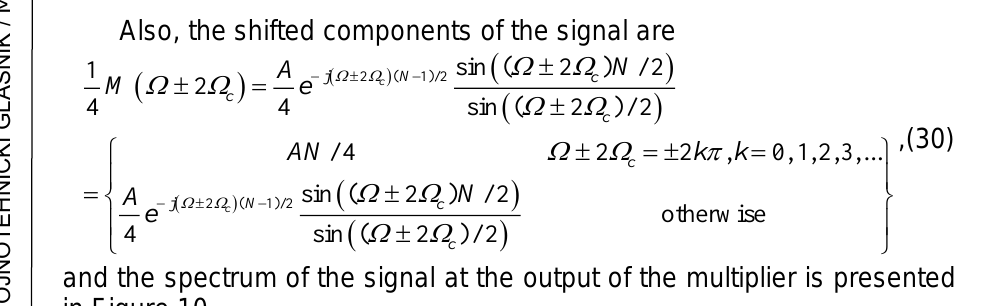
Figure 9 − Magnitude spectral density of the demodulated pulse Рис. 9 – Амплитудная спектральная плотность демодулированного импульса Слика 9 – Спектрална густина магнитуде демодулисаног пулса